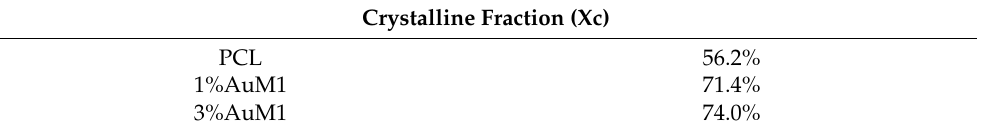
Table 4. Degree of Table 4. Degree of crystallinity.